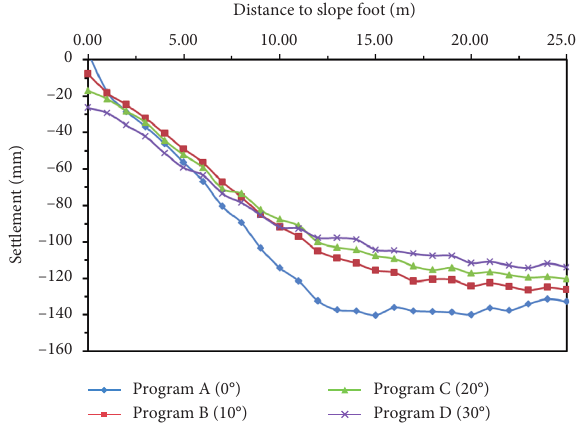
Figure 11: Settlement distribution curves of the embankment bottom